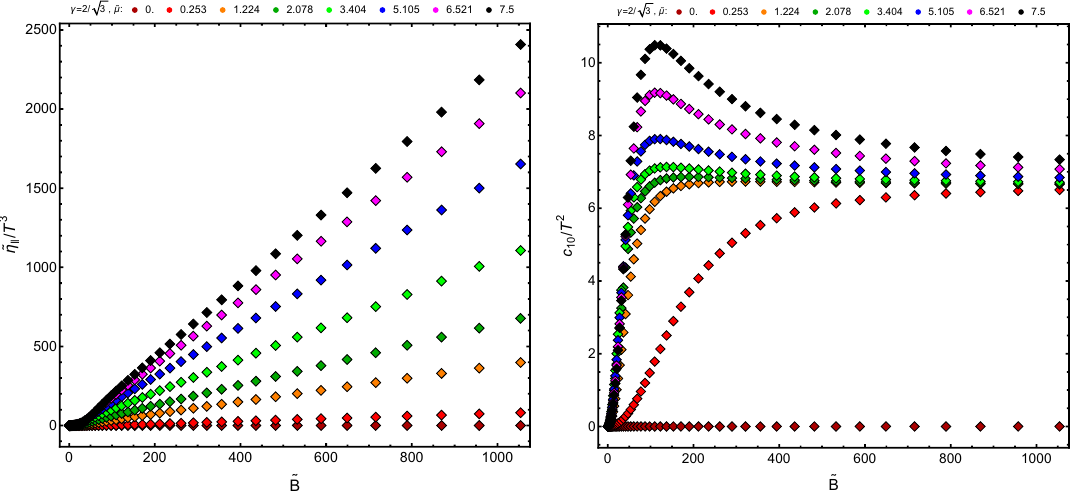
Figure 8 . The dissipationless transport coefficients ˜ η √ anomaly γ = 2 / 3 . Without chiral anomaly, both transport coefficients are